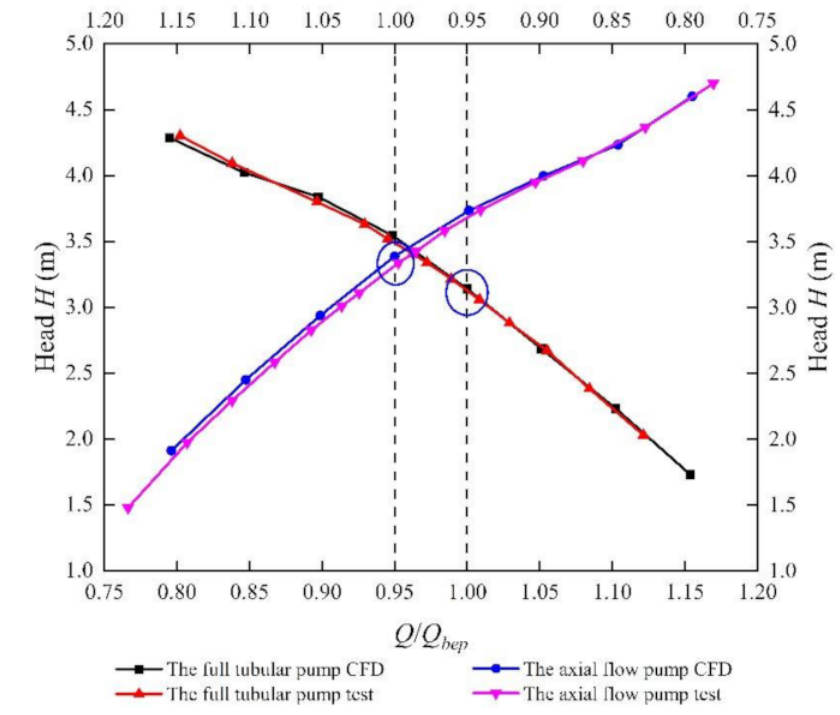
Figure 7. Performance curve